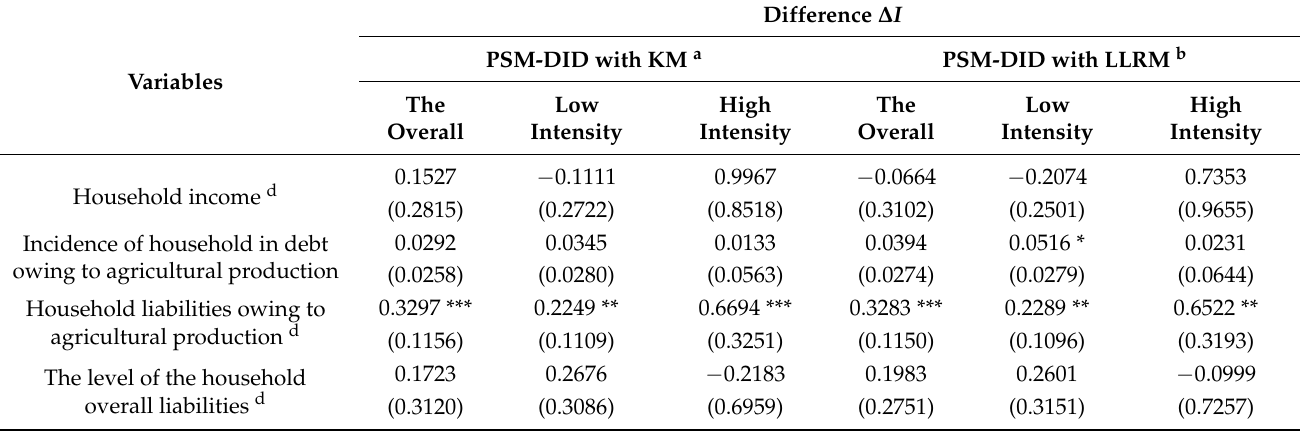
Table 7. Results of impact of land rental market participation on changes in household income and